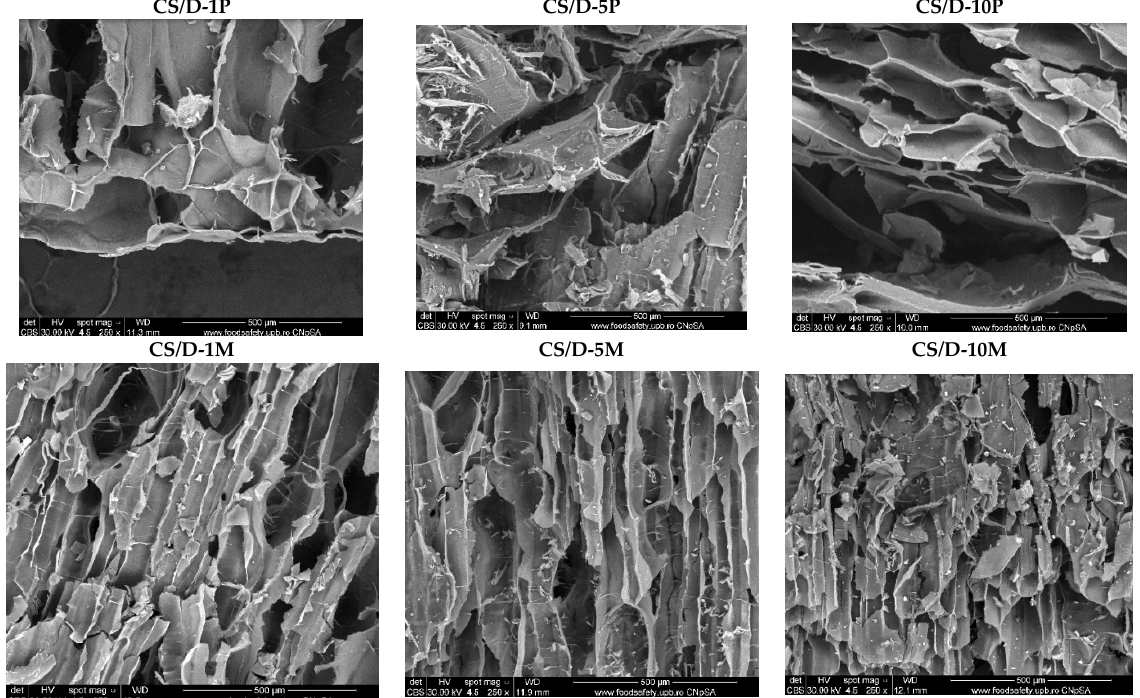
Figure 4. SEM images of the CS/D hydrogels (CBS detector).